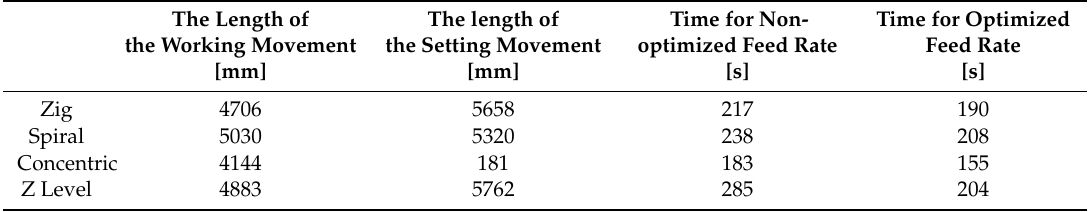
Table 8. List of tool path lengths and machining times using optimized and non-optimized NC